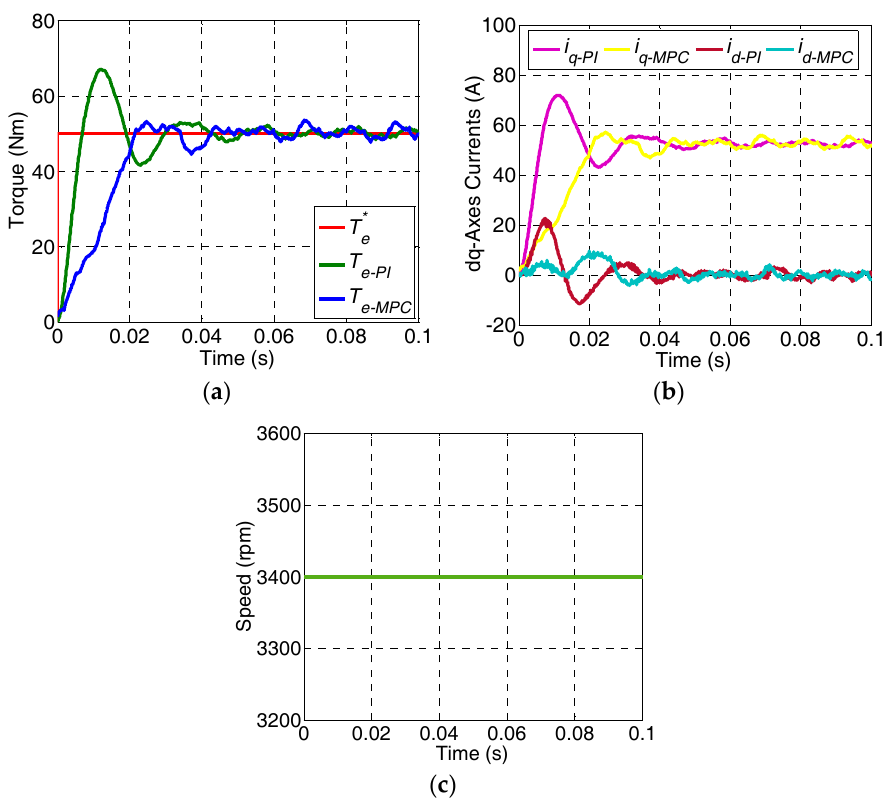
Figure 4. Simulation results under the step torque changing of the continuous-time model predictive control and proportional integralcontroller ( a ) Torque; ( b ) dq-Axes Currents; ( c ) Speed.